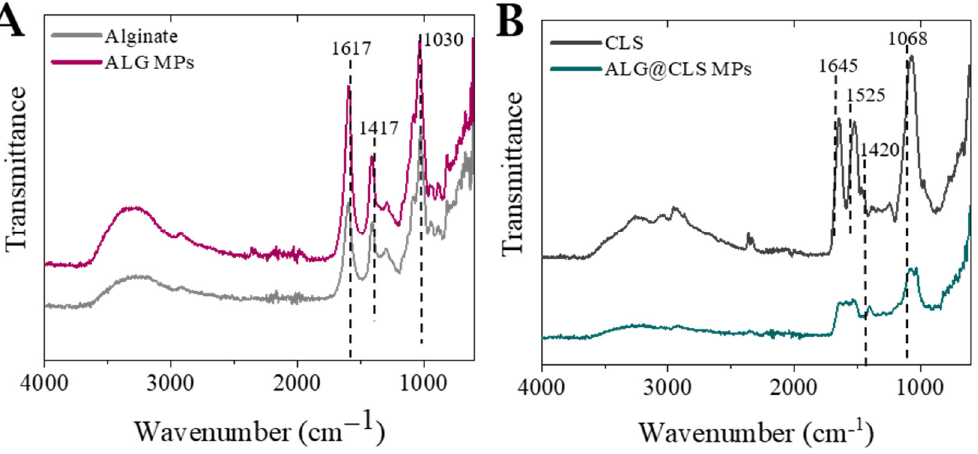
Figure 4. FTIR spectra of: ( A ) Raw alginate and Alginate MPs; ( B ) Raw Colistin Sulfate and ALG@CLS